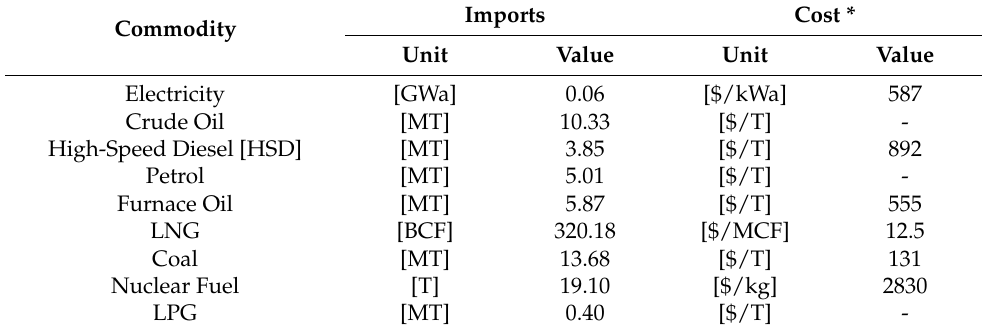
Table 15. Cost and quantity of imports